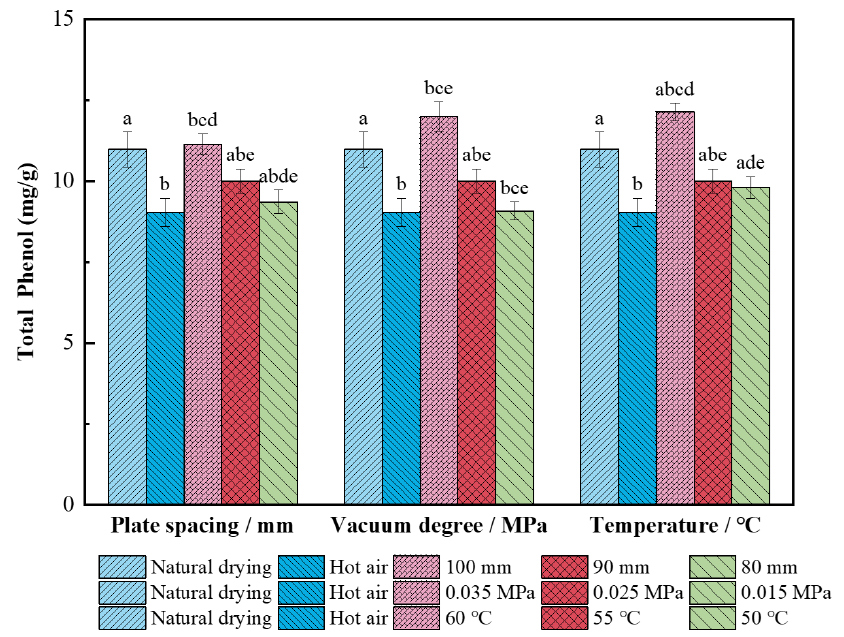
Figure 6. Total phenol content of L. barbarum under different drying conditions. Significant differences are represented by different letters ( p < 0.05).